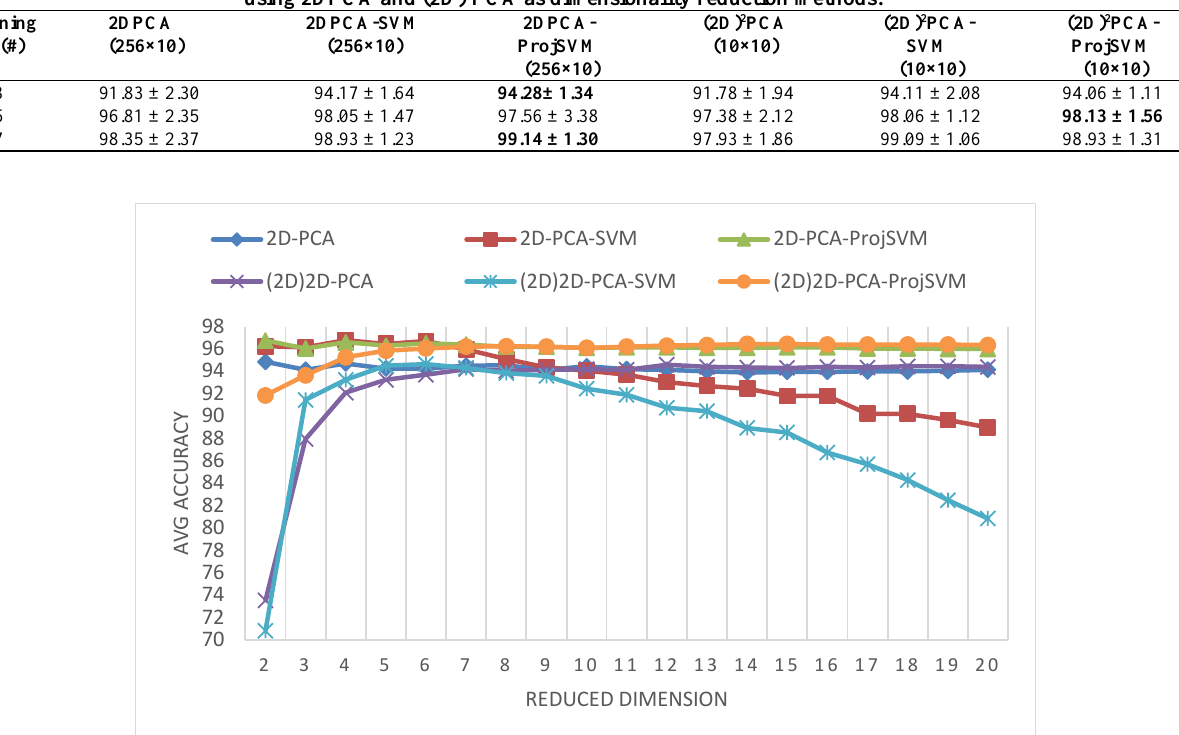
Table 3. Mean classification accuracy (in percent) over 10 random runs for JAFFE dataset with reduced dimension of 10 using 2DPCA and (2D) 2 PCA as dimensionality reduction methods.